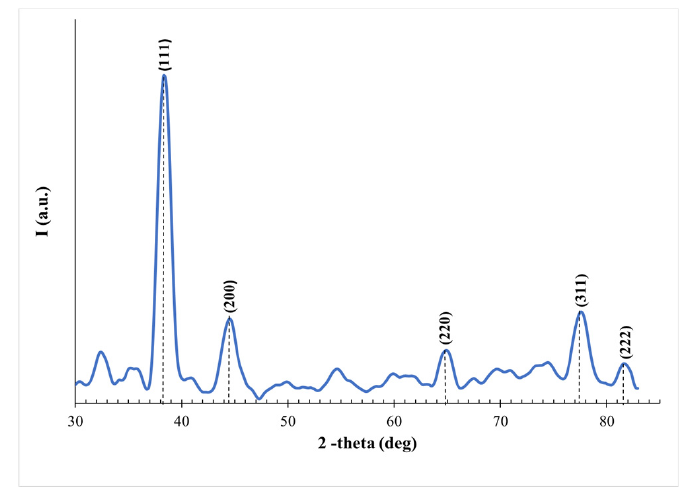
Figure 3. XRD spectrum of the produced Ag NPs.